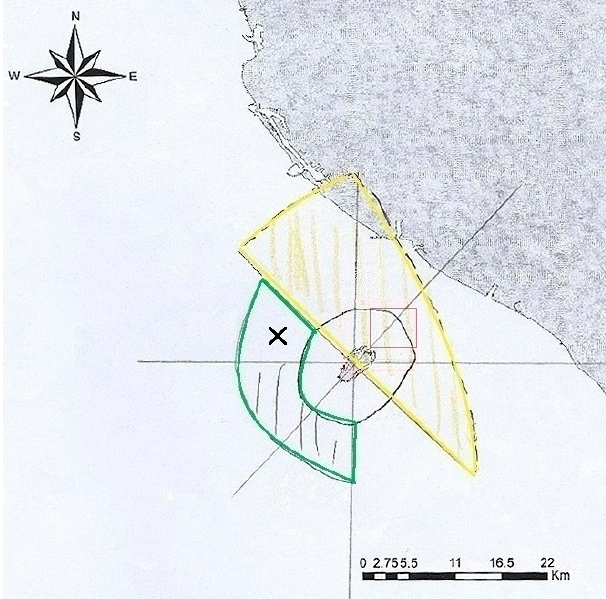
Figure 3. Location of the offshore platform, as proposed by the stakeholders (black cross: proposed location, black circle: 3 nautical miles radius, red square: initially proposed location, green area: suitable area for OTEC (ocean thermal energy conversion), yellow area: fishing grounds). Table 2. List of the topics.